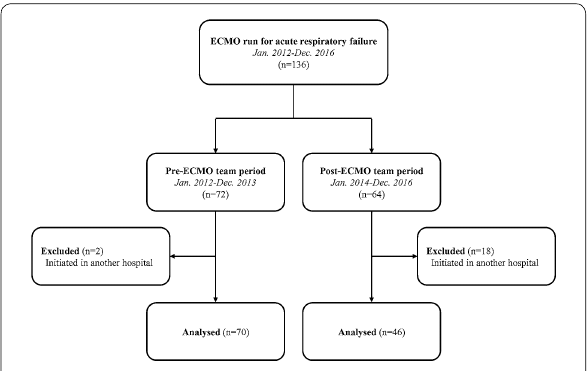
Fig. 1 Patient distribution between the two